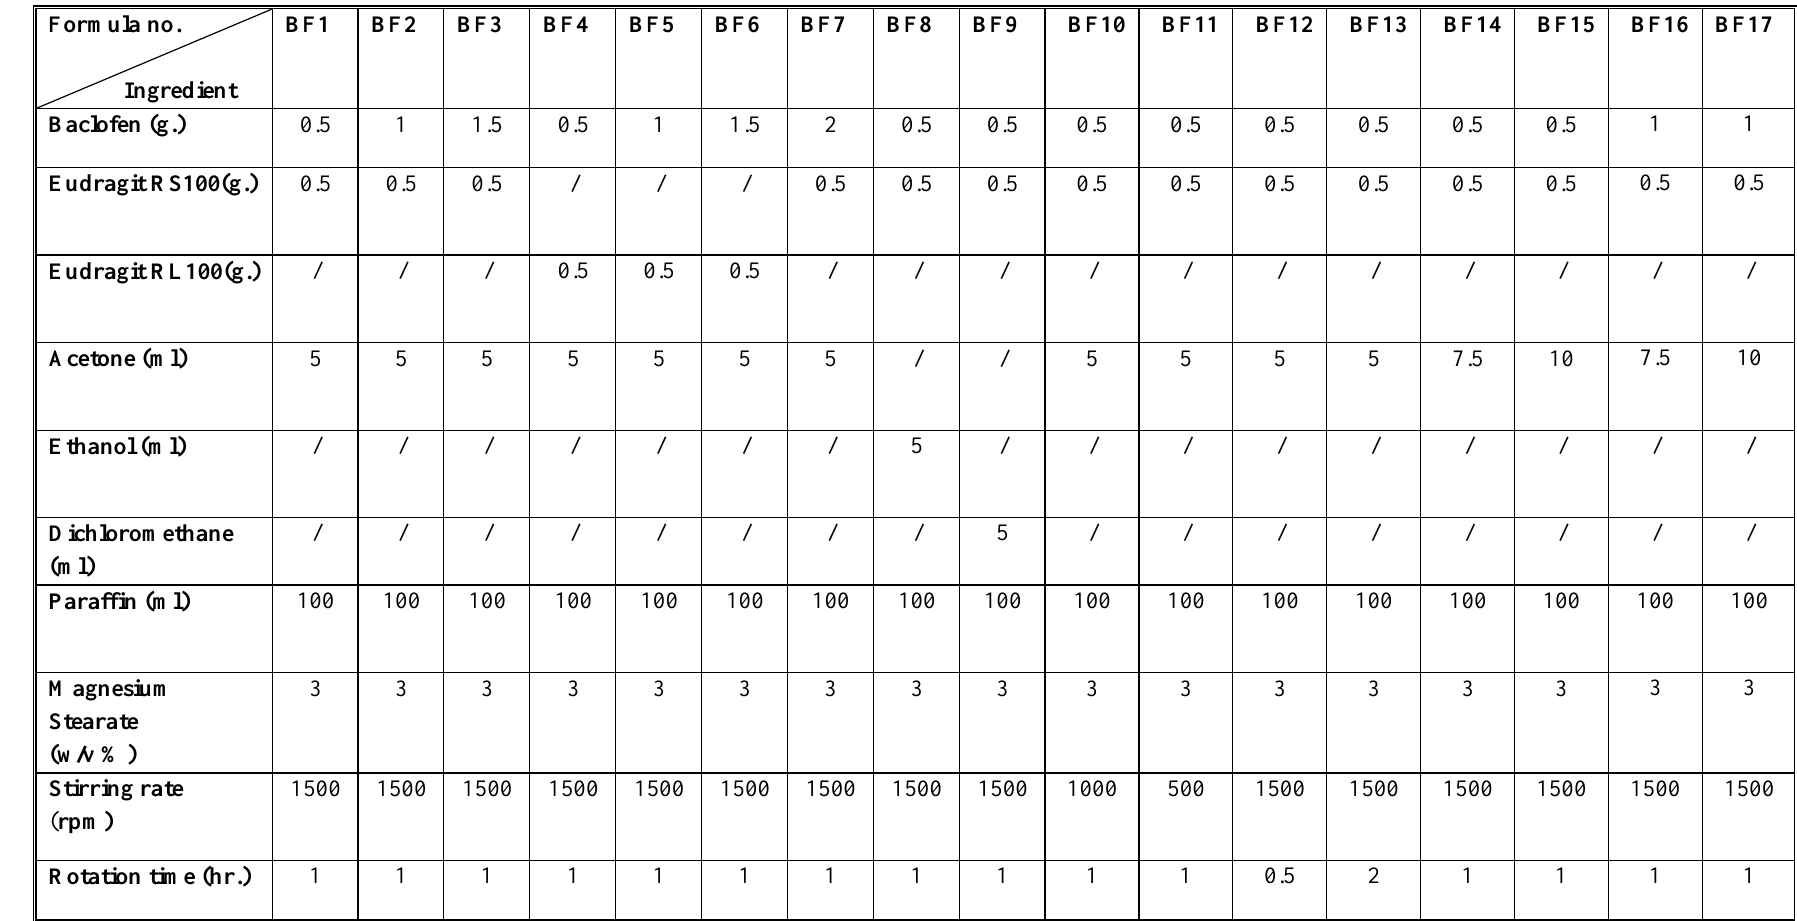
Table (1) Formulas of BFN microsponges Formula no.